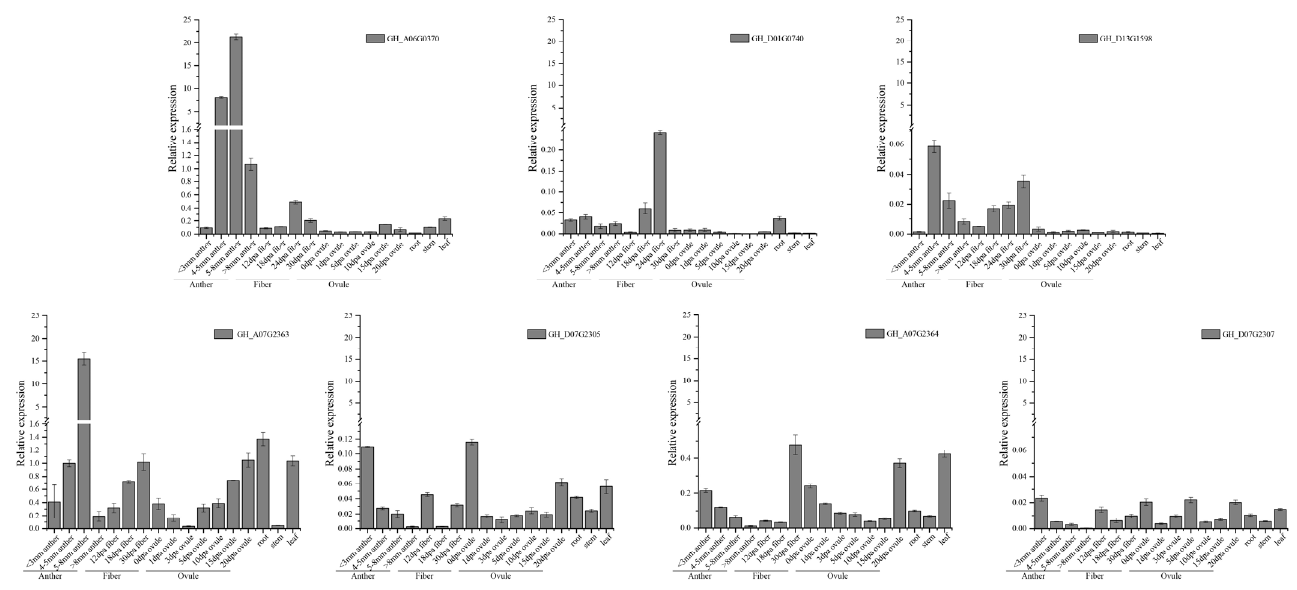
Figure 8. Expression levels of seven GhFBXLs in different tissues. GhActin was selected as an internal reference for the expression analysis of cotton genes. Error bars represent the standard deviation calculated from three independent experiments.